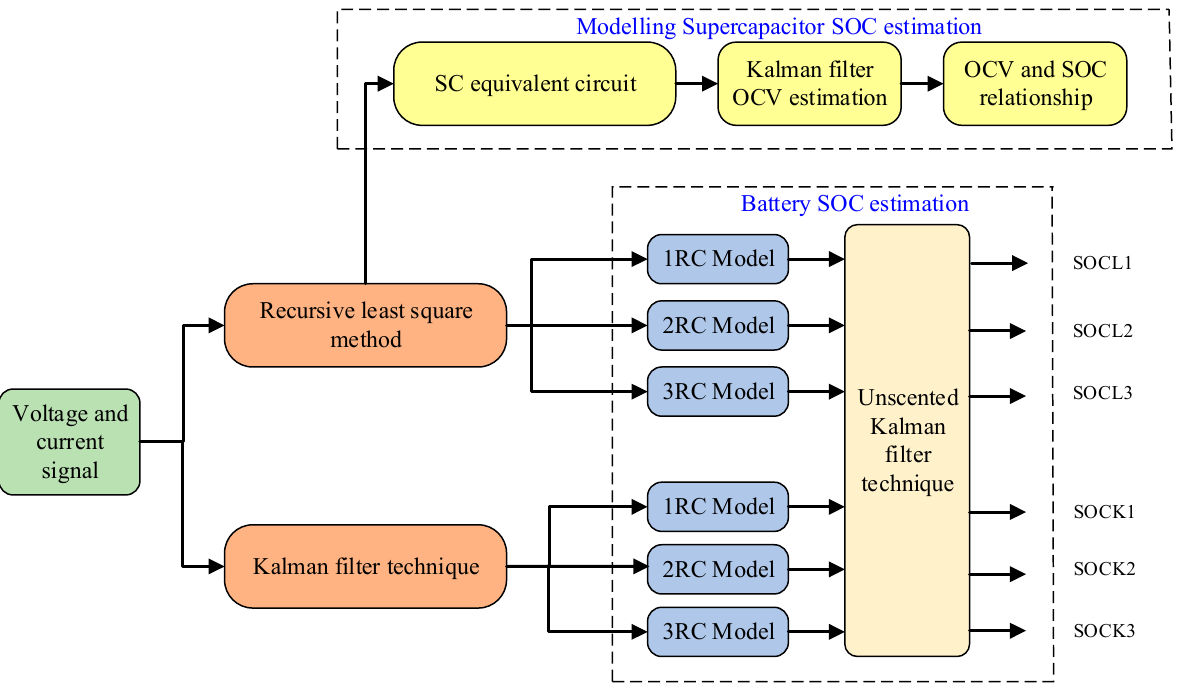
Figure 6. Improved KF based technique for SOC estimation of